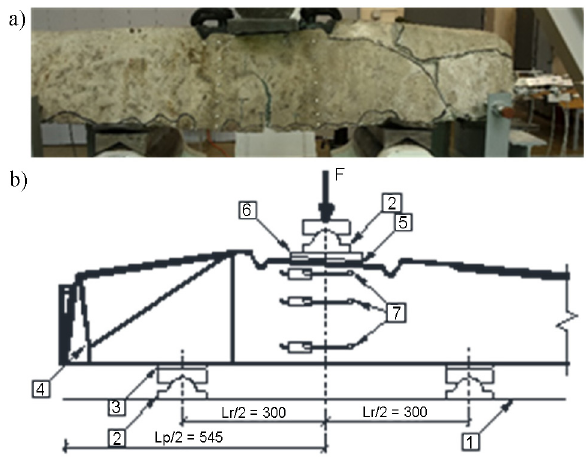
Fig. 4. Arrangement of strain measurement devices: a) testing view with DEMEC gauges; b) testing scheme with LVDT gauges. 1 – rigid support; 2 – hinge support; 3 – elastic pad; 4 – prestressed concrete monoblock sleeper; 5 – standard rail pad; 6 – inclined